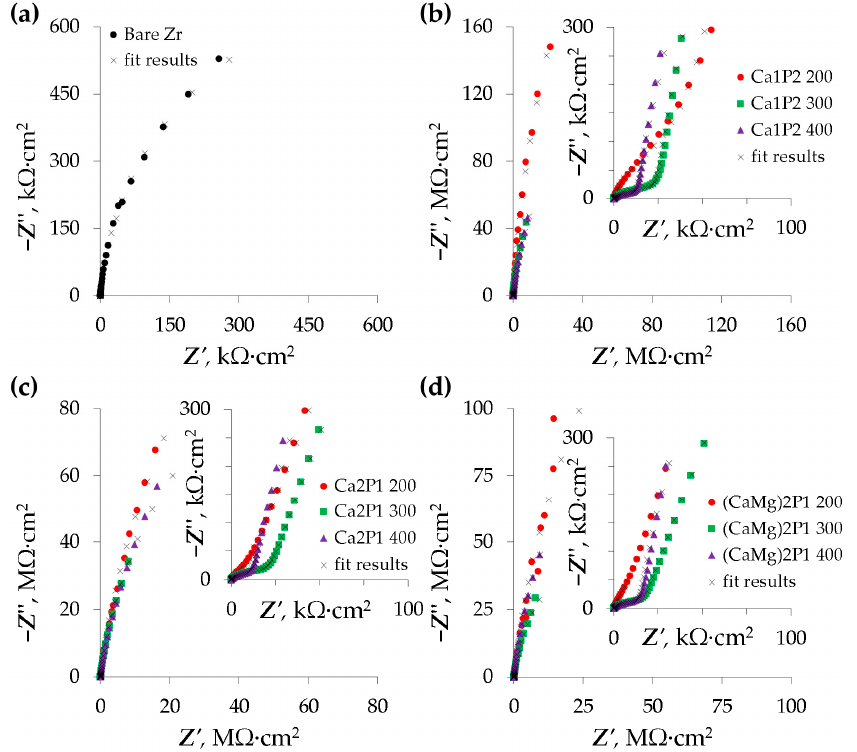
Figure 7. Complex plane Nyquist plots of impedance spectra belonging to the bare zirconium surface ( a ) and the PEO coatings formed in the Ca1P2 ( b ), Ca2P1 ( c ), as well as (CaMg)2P1 ( d ) solutions.